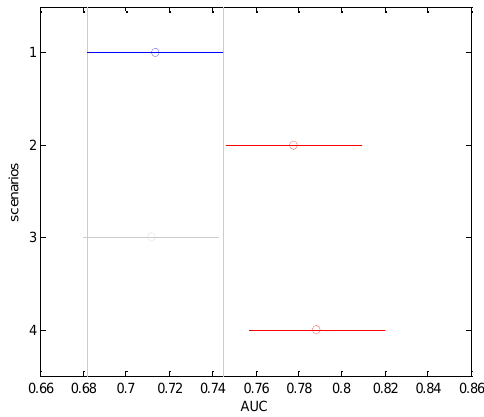
Figure 13. Multiple comparison for four scenarios.